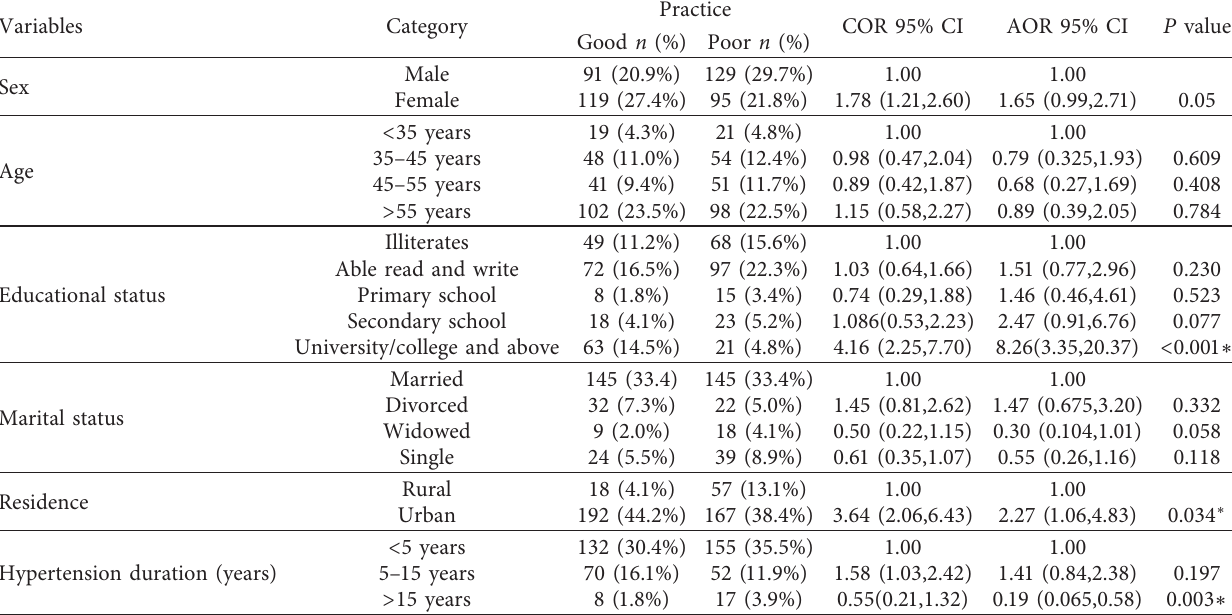
Table 5: Bivariate and multivariate analysis of factors associated with preventive practice towards CKD.